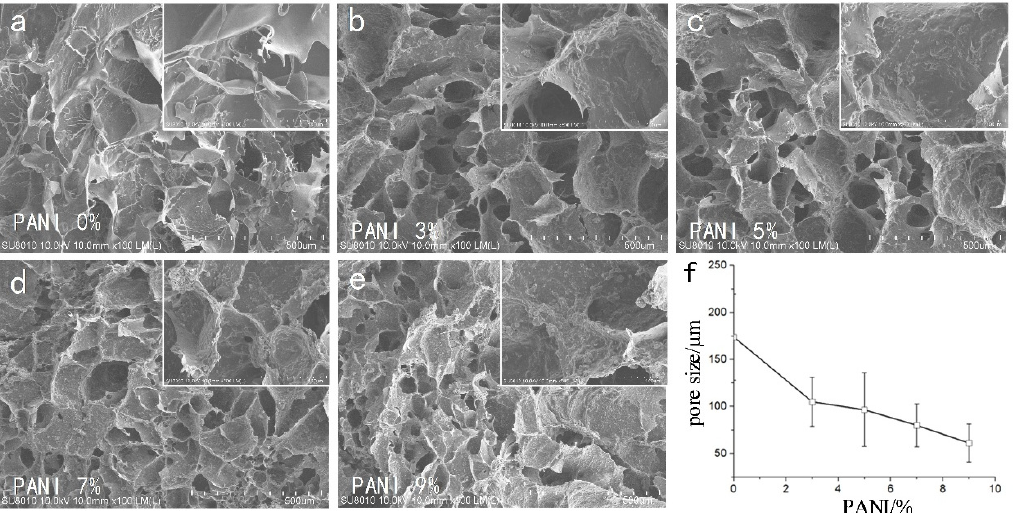
Figure 3. Porous structure of the bio conductive materials with different polyaniline concentrations. ( a – e ). SEM images of bio conductive materials at 0%/3%/5%/7%/9% polyaniline concentration. ( f ) Pore change curve of bio conductive materials with different polyaniline concentrations.